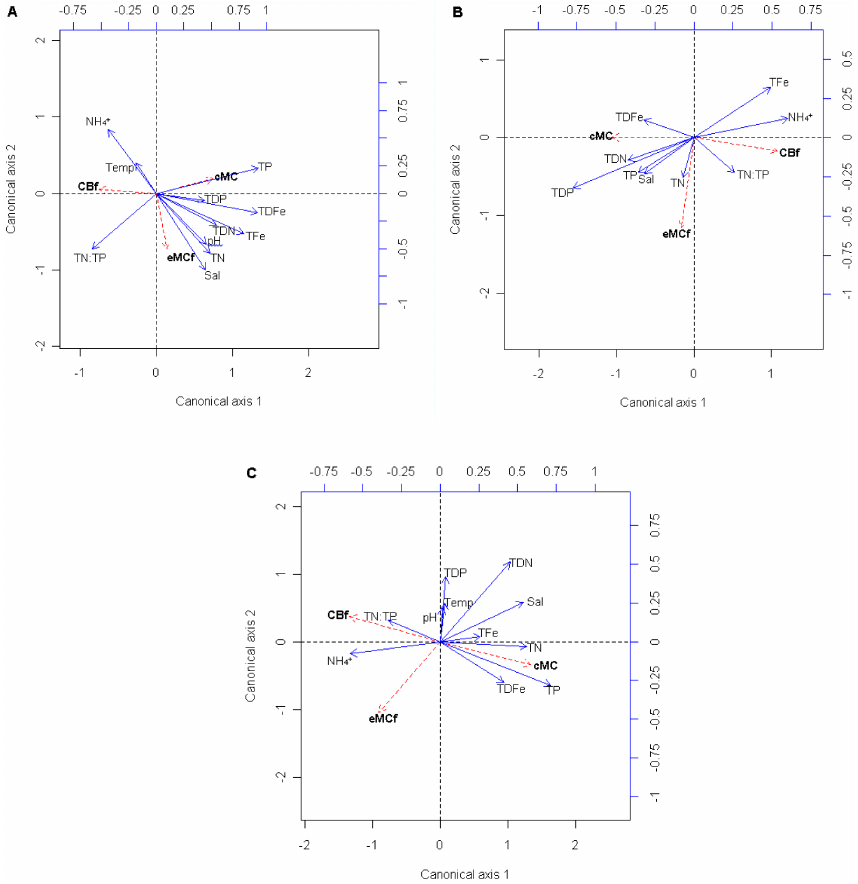
Figure 9. RDA biplots for the environmental variables and the cyanobacterial fraction (CBf), cellular microcystin (cMC) and extracellular microcystin fraction (eMCf) in (a) Jackadder Lake, (b) Bibra Lake, (c) Yangebup Lake; solid arrows indicate environmental variables; short dashed arrows indicate response variables. Canonical axes 1 and 2 represent a linear combination of the environmental variables, and axes are scaled by the square root of their